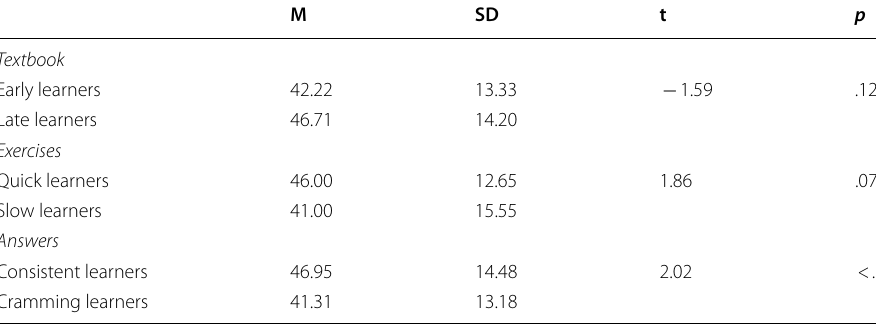
Table 3 Difference between DP clusters on performance